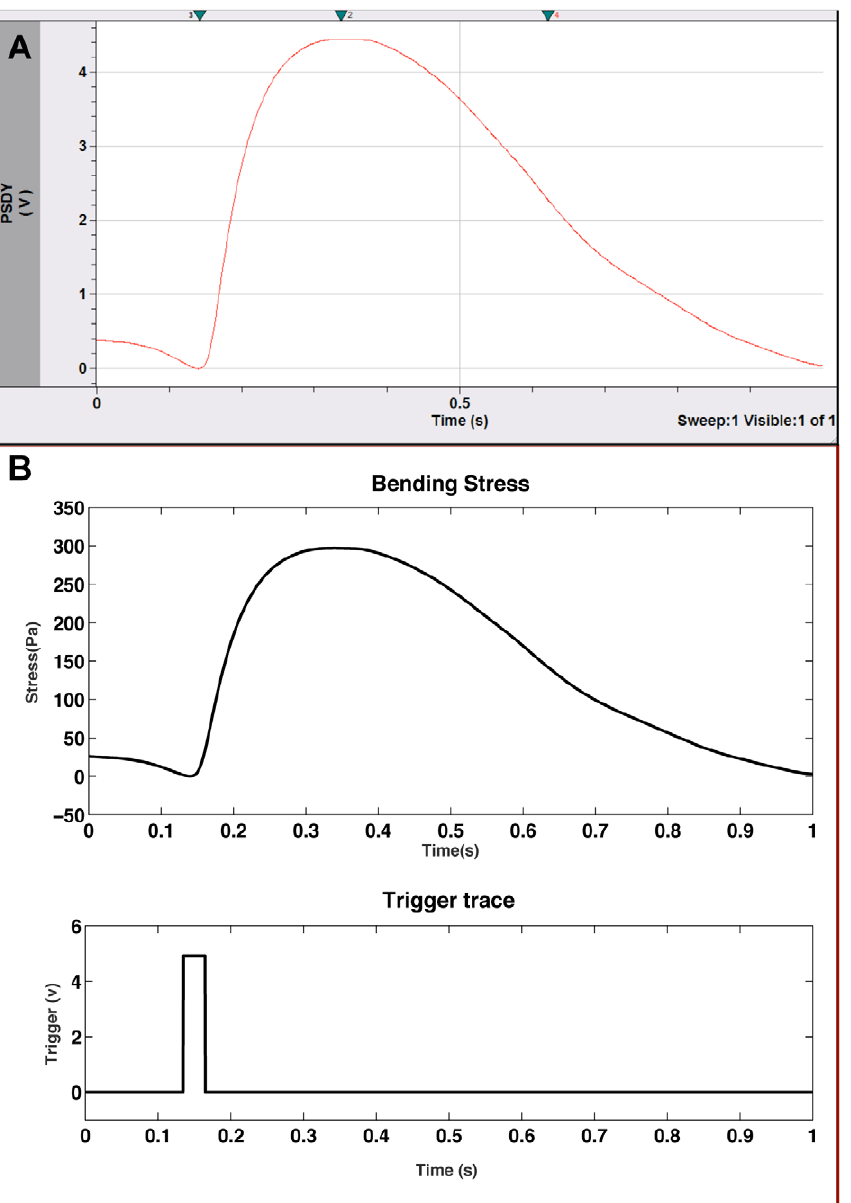
Figure 5. Averaged data from 11 myotube contractions. A) Raw data, B) Estimated stress calculated using the modified Stoney’s equation.